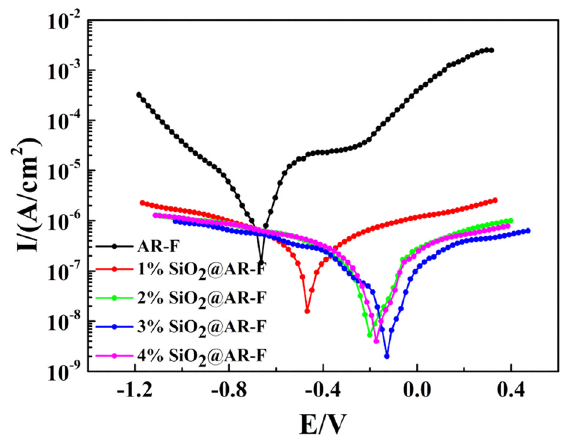
Figure 8: Polarization curve of potential dynamics.